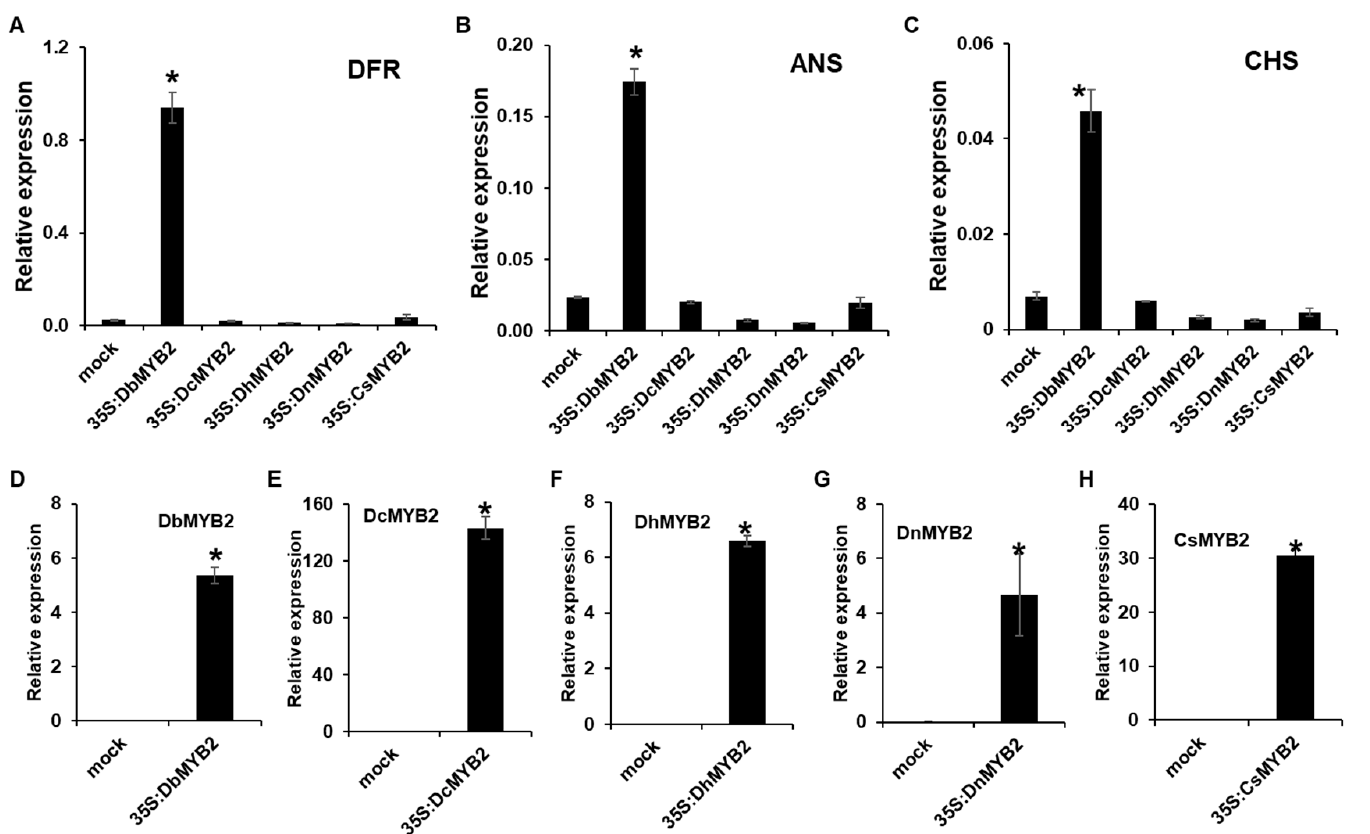
Figure 8. Transient expression of DbMYB2s were associated with increased expression of ANS, DFR, and CHS in N. benthamiana . ( A – C ) Real-time quantitative RT-PCR showing relative expression levels of NbDFR , NbANS , and NbCHS genes in N. benthamiana transiently overexpressing MYB2 genes from di ff erent orchids. ( D – H ) Real-time quantitative RT-PCR showing relative expression levels of MYB2 genes in N. benthamiana plants transiently overexpressing MYB2 orthologs from di ff erent orchids. The error bars indicate SD ( n = 4). Results are representative of three independent experiments. Asterisks denote a significant di ff erence with mock and MYB2 overexpressed plants ( t -test, p <